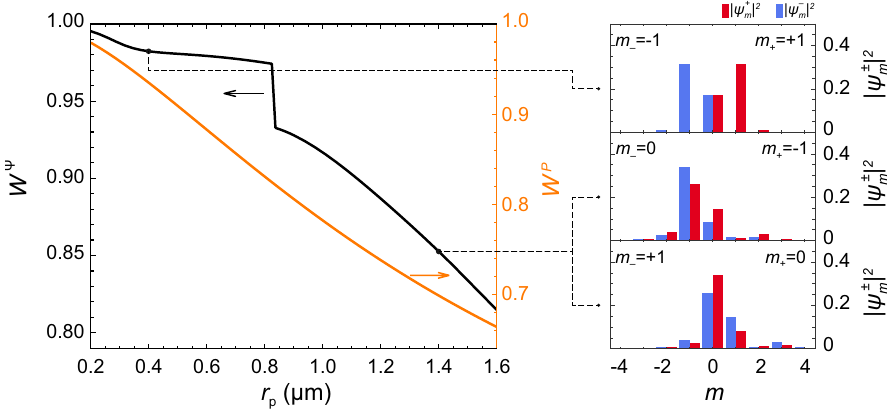
Figure 3. Variation of the spectral width of the wave function. The dependence of the contribution of the population of three central spectral components ( m = 0 and ± 1 ) of the decomposition (3) to the final polariton state, W Ψ (black curve), and the contribution of the three central components of the optical pump, W P (orange curve). The right panels show the populations of the vortex states with the winding numbers m from − 4 to + 4 contributing to the final polariton states indicated in the main